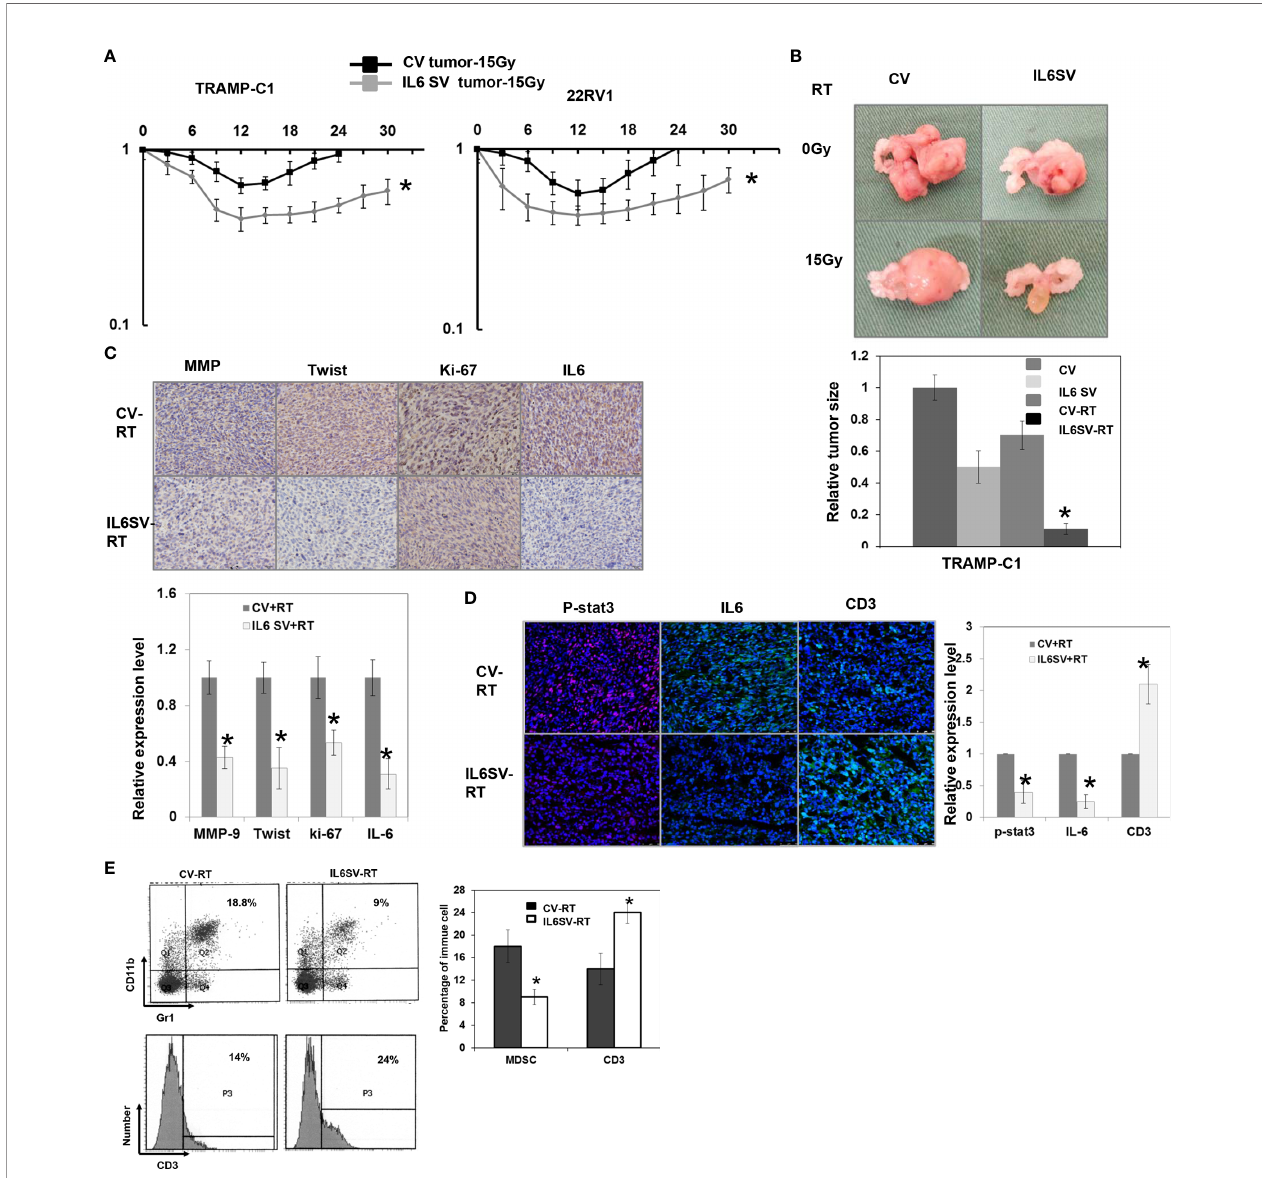
FIGURE 2 | Effects of IL6 on radiation responses in vivo. (A) The effect of IL-6 on the radiosensitivity of prostate cancer (22RV1 and TRAMP-C1), as demonstrated by tumor growth delay of the ectopic tumor after 15 Gy irradiation (CV: cells transfected with control vectors; IL6 SV: cells transfected with IL6 silencing vectors), and (B) The relative tumor size of orthotopic tumor at 12 days after 15Gy irradiation or sham irradiation. The relative tumor size was normalized to the CV tumor size 12 days after sham irradiation (CV-RT: orthotopic tumor of cells transfected with control vectors after 15Gy irradiation; IL6 SV-RT: orthotopic tumor of cells transfected with IL6 silencing vector after 15Gy irradiation). (C) The effect of IL6 SV on tumor regrowth after irradiation is demonstrated by IHC using Ki-67, MMP-9, and twist staining (CV-RT: tumor of cells transfected with control vectors after 15Gy irradiation; IL6 SV-RT: tumor of cells transfected with IL6 silencing vector after 15Gy irradiation), and (D) the tumor in fi ltrating CD3-positive T cells by immuno fl uorescence in vivo (DAPI, blue; p-STAT3, red; IL-6/CD3, green). Representative images are shown. The quanti fi cation is to calculate the value of the cell number positive for targeted protein divided by the total cell number. The Y-axis represents the ratio normalized by the value of irradiated CV cells. *p < 0.05. (E) IL6 inhibition was associated with attenuated myeloid-derived suppressor cells (MDSC) recruitment and increased in fi ltration of CD3+ T cells in tumors by